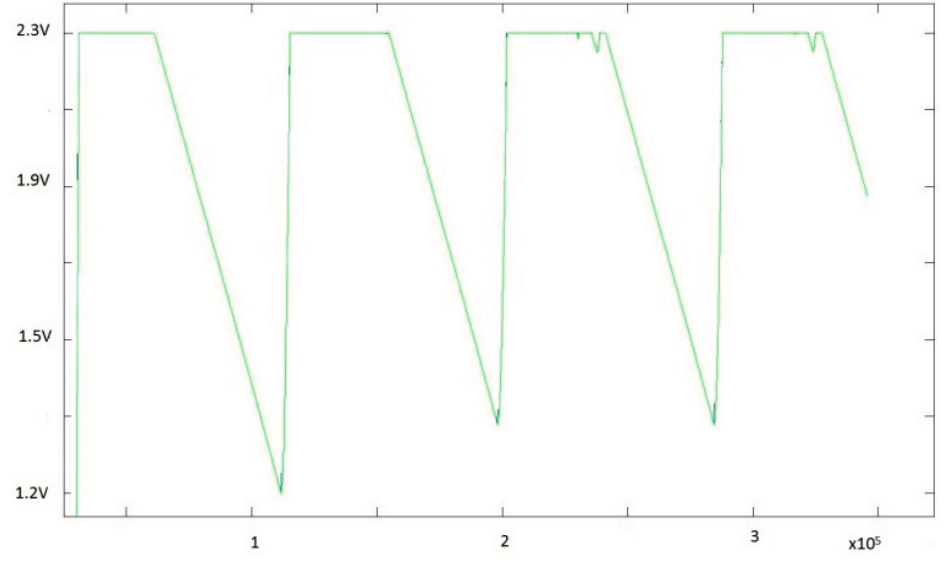
Figure 12. Energy demanded by the capacitor in terms of voltage level (3-days